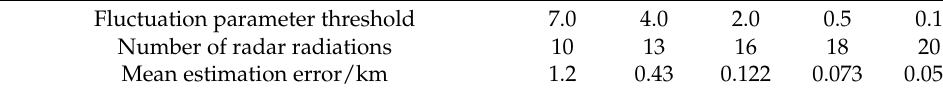
Table 4. The comparison of fluctuation parameter